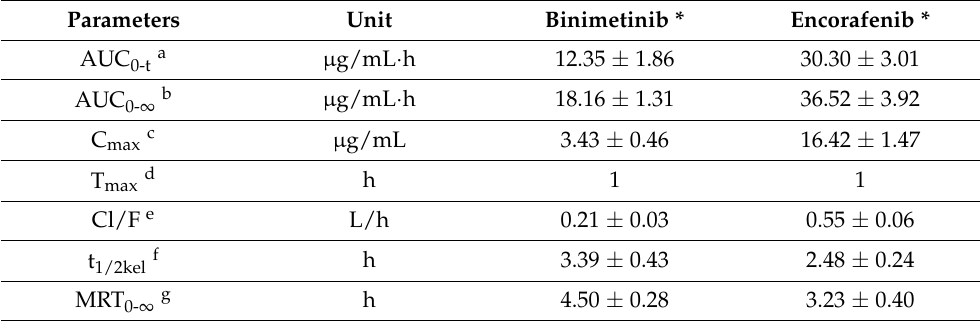
Table 7. The pharmacokinetic parameters of binimetinib and encorafenib in rat plasma after oral administration of 3.8 mg/kg binimetinib and 20 mg/kg encorafenib (n = 6, mean ± SD).